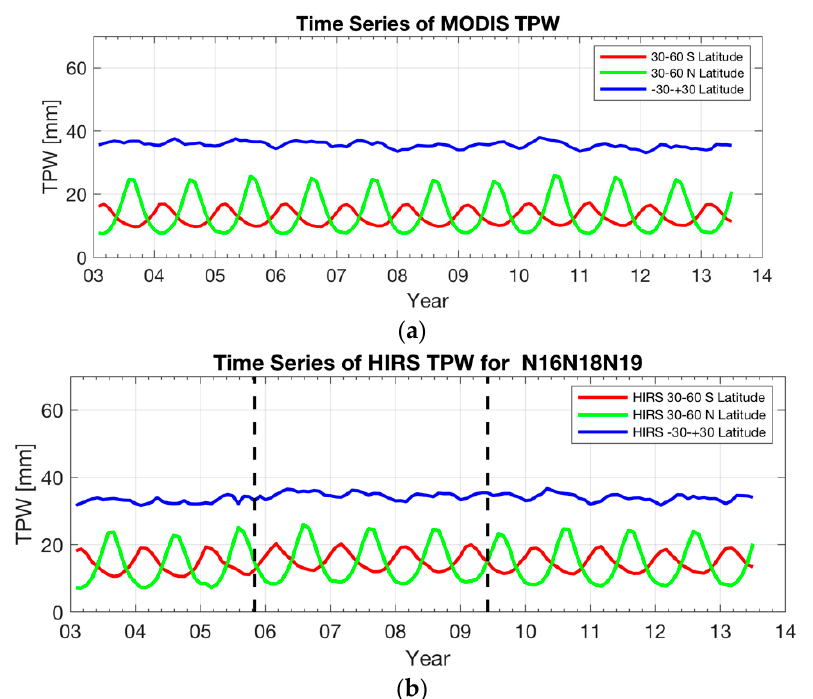
Figure 3. Time Series of TPW detection for Aqua MODIS ( a ) and NOAA-16, -18, and -19 HIRS ( b ) from 2003 to 2014 for five latitude bands (mid latitude north 30 ◦ to 60 ◦ N, tropics 30 ◦ N to 30 ◦ S, and mid latitude south 30 ◦ to 60 ◦ S).